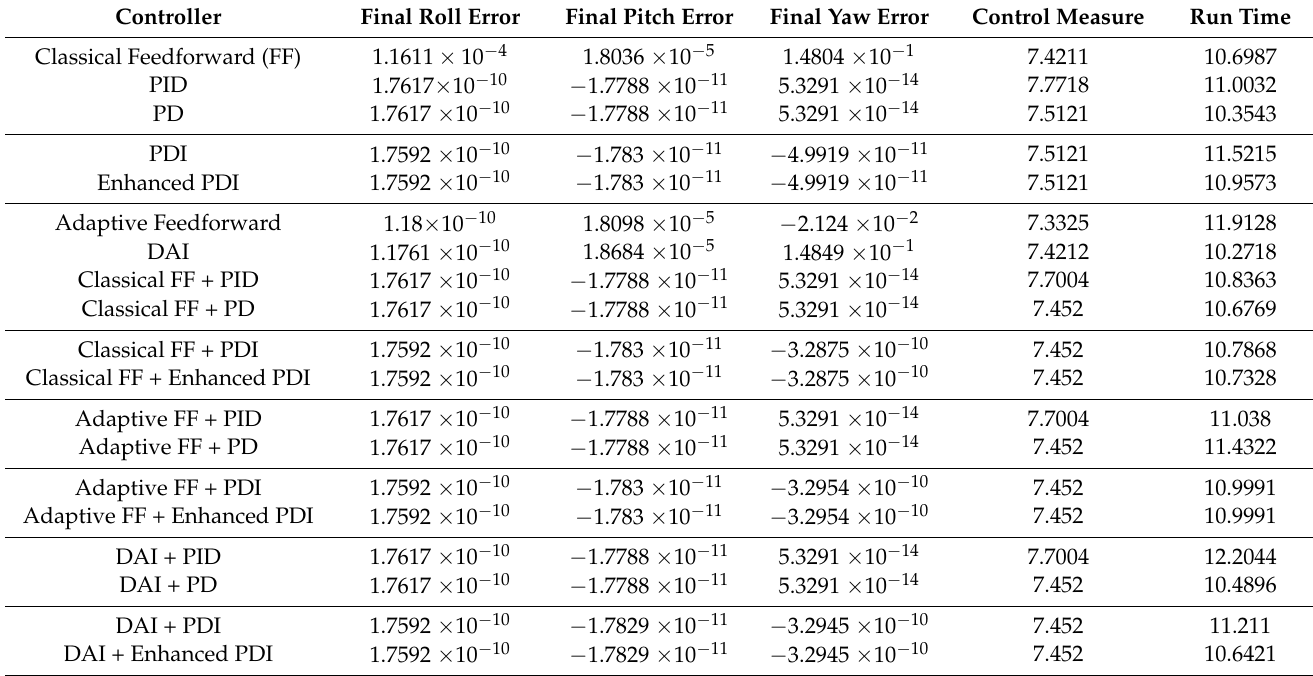
Table 1. System responses for various controller architectures in response to sinusoidal trajectory for a symmetric spacecraft.